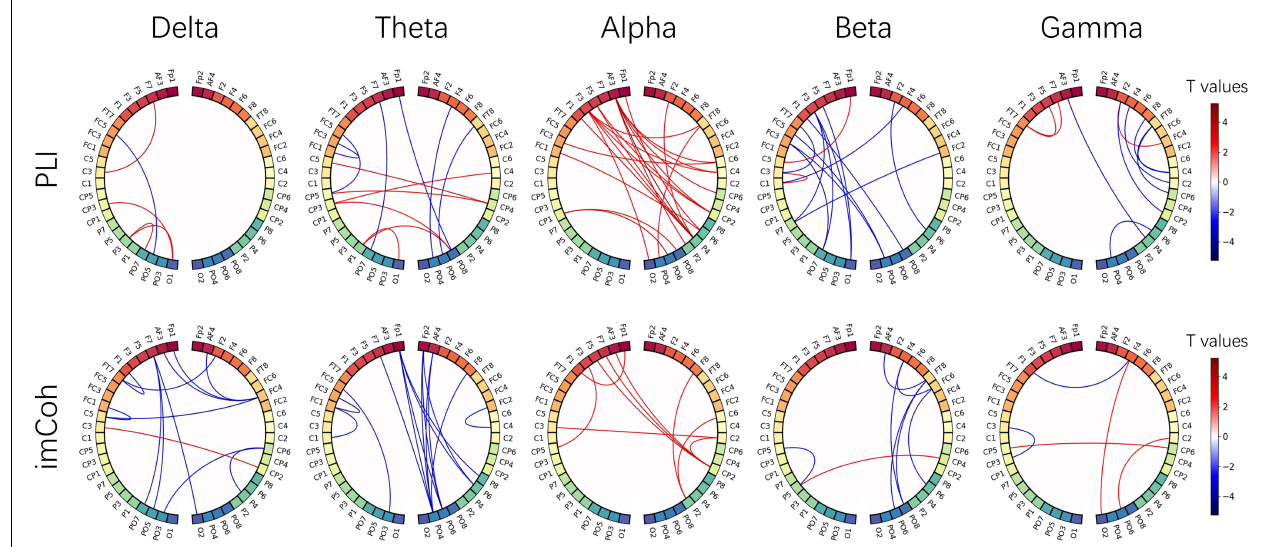
FIGURE 8 | The functional connectivity difference from five frequency bands, calculated by the phase lag index (PLI) and imaginary coherence (imCoh). The nodes correspond to 48 electrodes from bilateral hemispheres, and the links represent the statistical values resulting from a paired t -test between pre- and post-NFT baseline sessions. The red and blue color of the line indicates that the connection was enhanced or weakened after alpha NFT, respectively. Only significant links ( p < 0.01) are illustrated -whereas no significance was found after the FDR